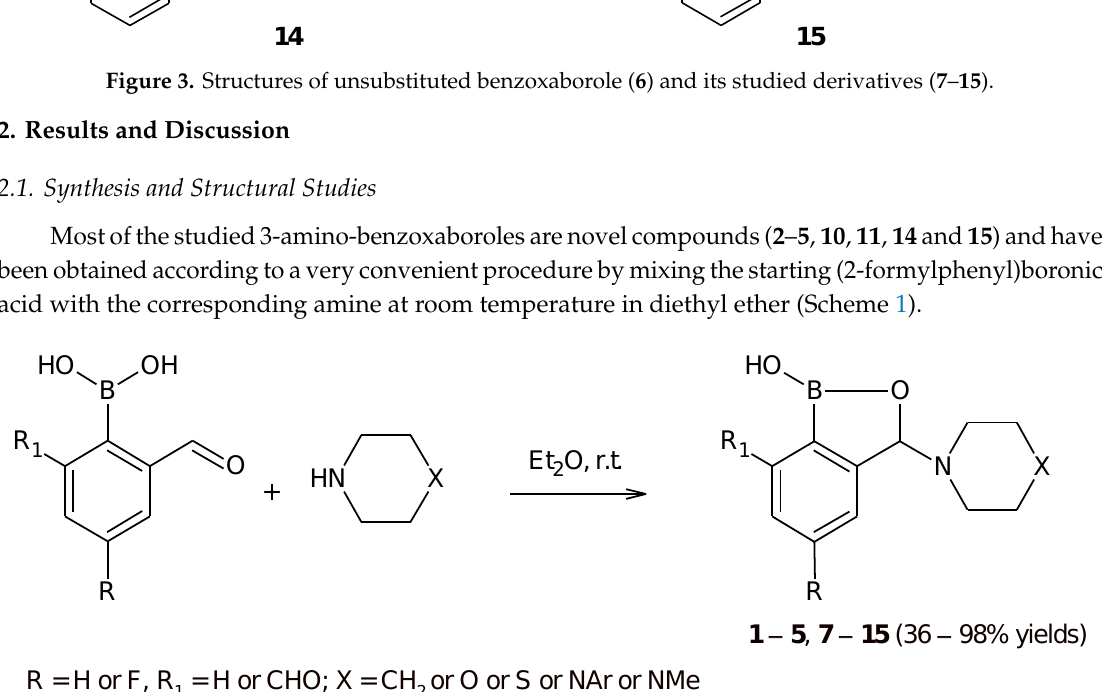
Scheme 1. Synthetic procedure for the studied 3-aminobenzoxaboroles.